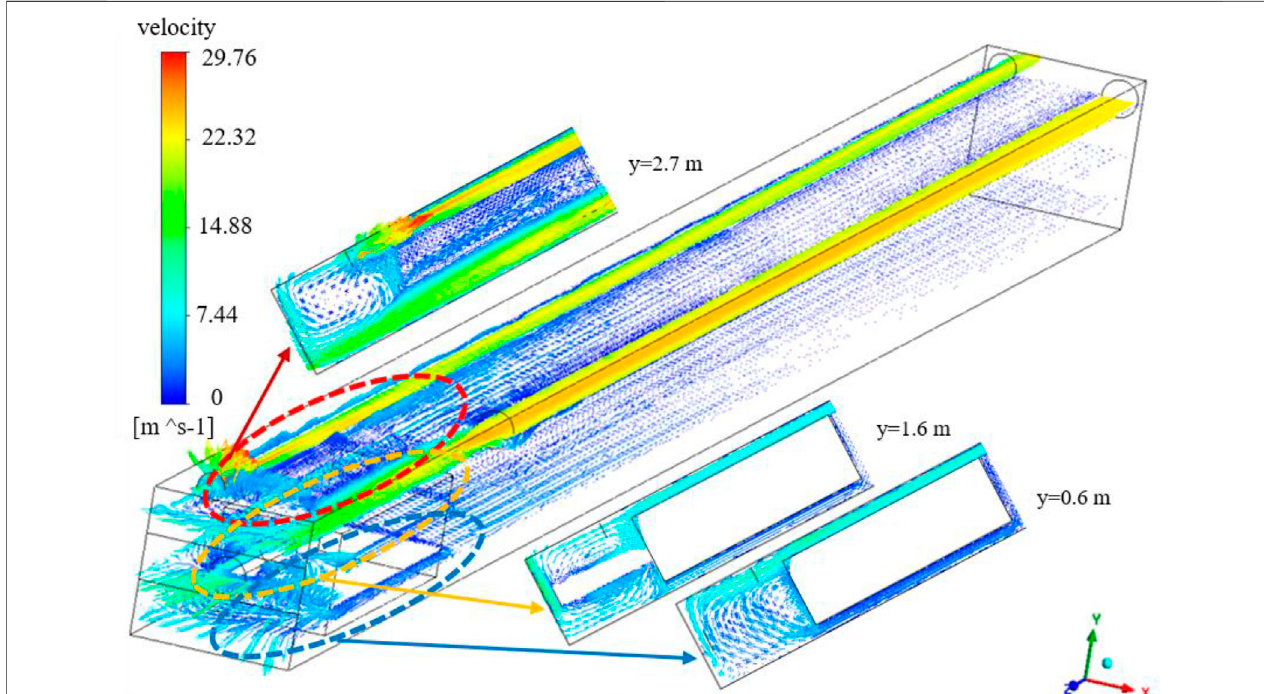
FIGURE 4 | Numerical simulation of air fl ow